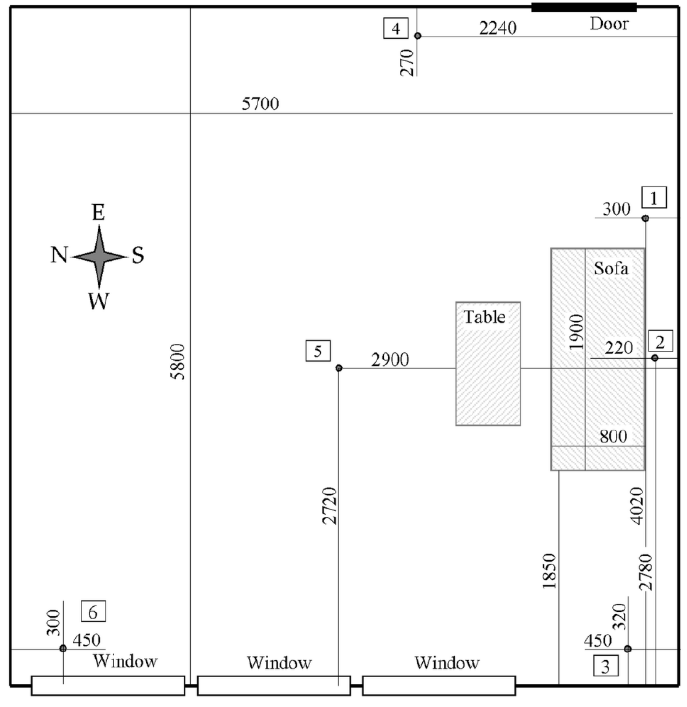
Figure 2. The test room (distances given in mm).